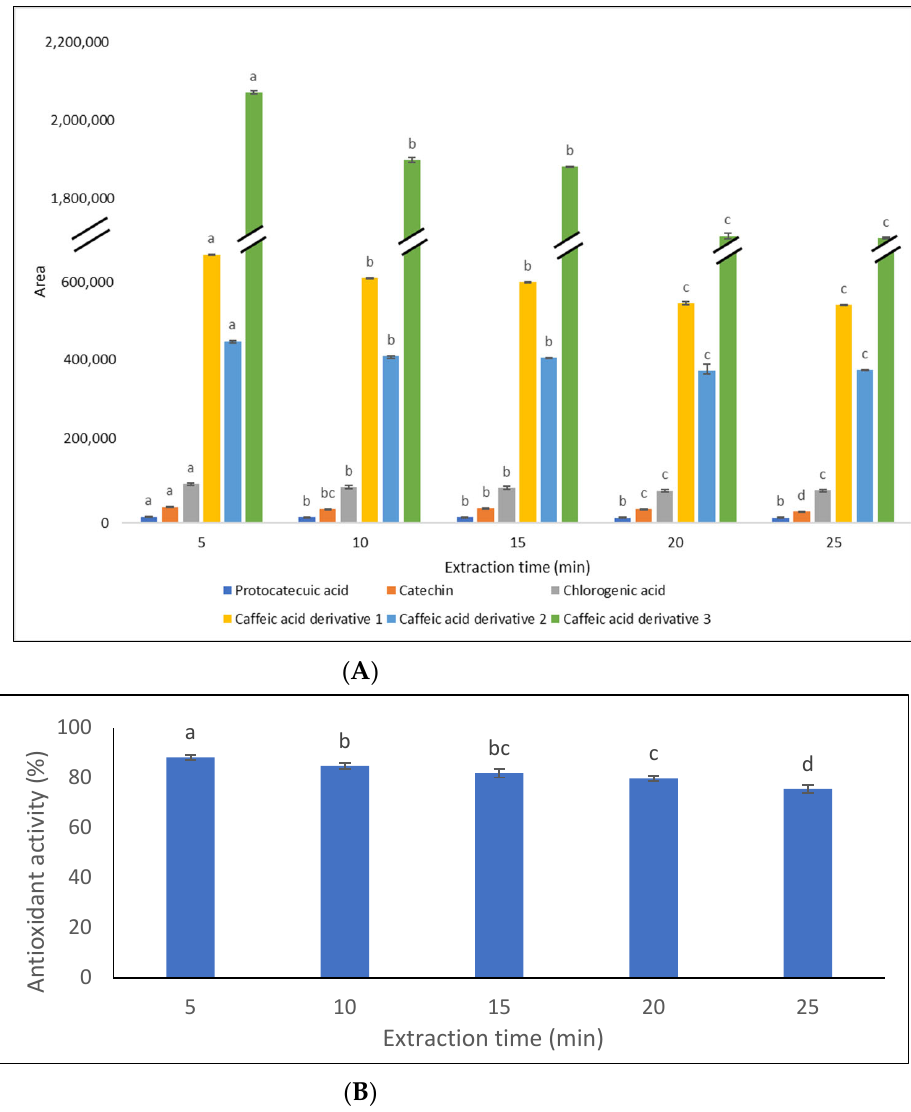
Figure 4. The kinetic study of phenolic compounds ( A ) and antioxidant activity ( B ) in the young coconut mesocarp under optimum UAE extraction conditions (5 min of extraction time, 70 °C of temperature, 0.55 s − 1 of pulse duty cycle, and 20:1 mL g − 1 of solvent ‐ to ‐ sample ratio). Bars with different letters indicate significant differences at a p < 0.05 based on Duncan’s multiple range test.